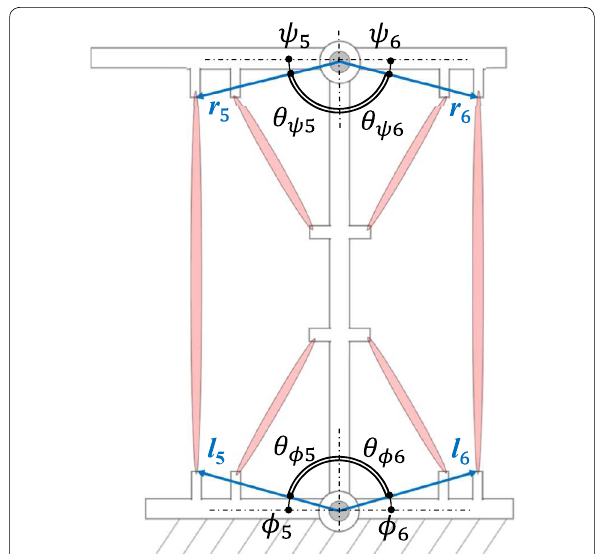
Fig. 7 Symbols used for the biarticular muscular arrangement